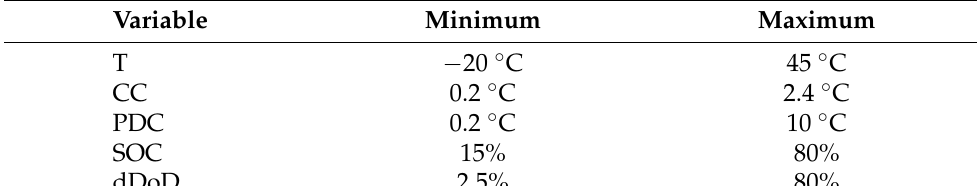
Table 2. Impact factors for the accelerated ageing tests.